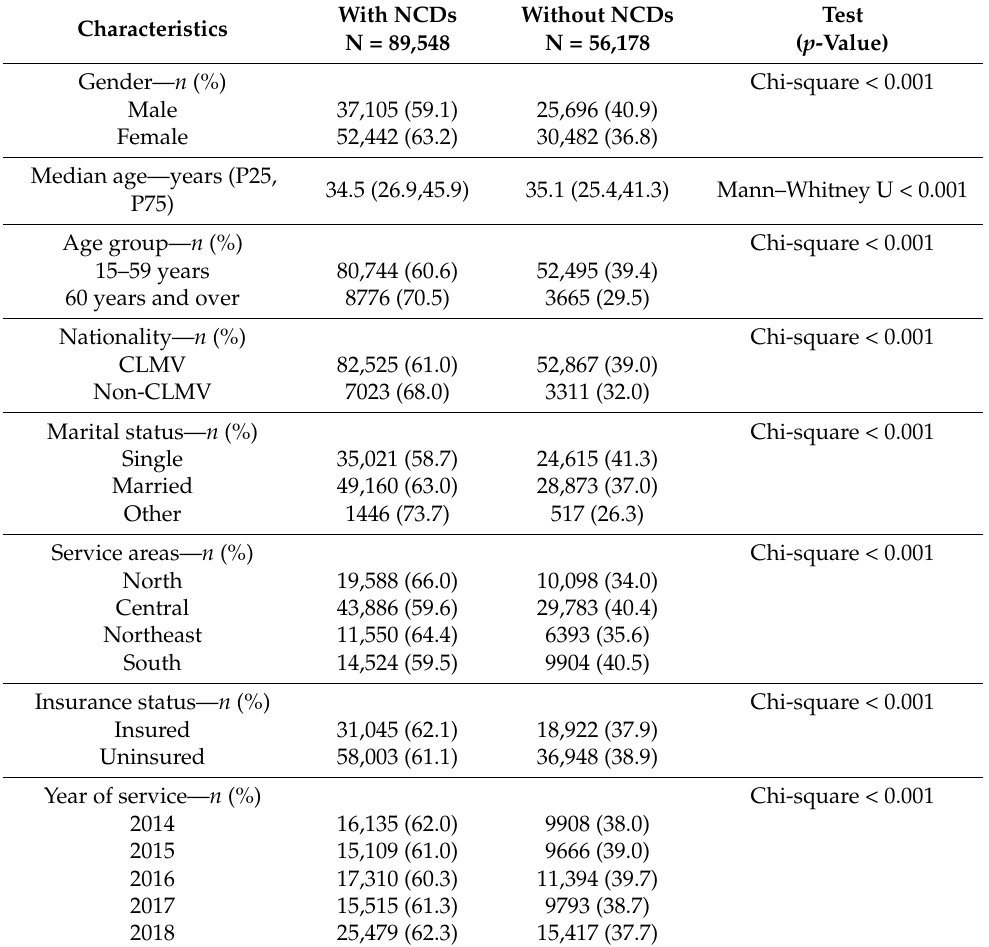
Table 1. Demographic characteristics of expatriate patients attending OP services in